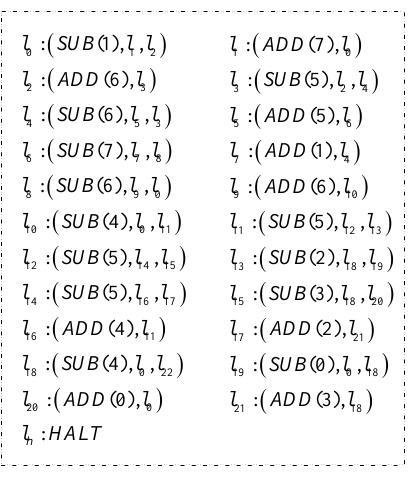
Figure 9. The universal register machine M u